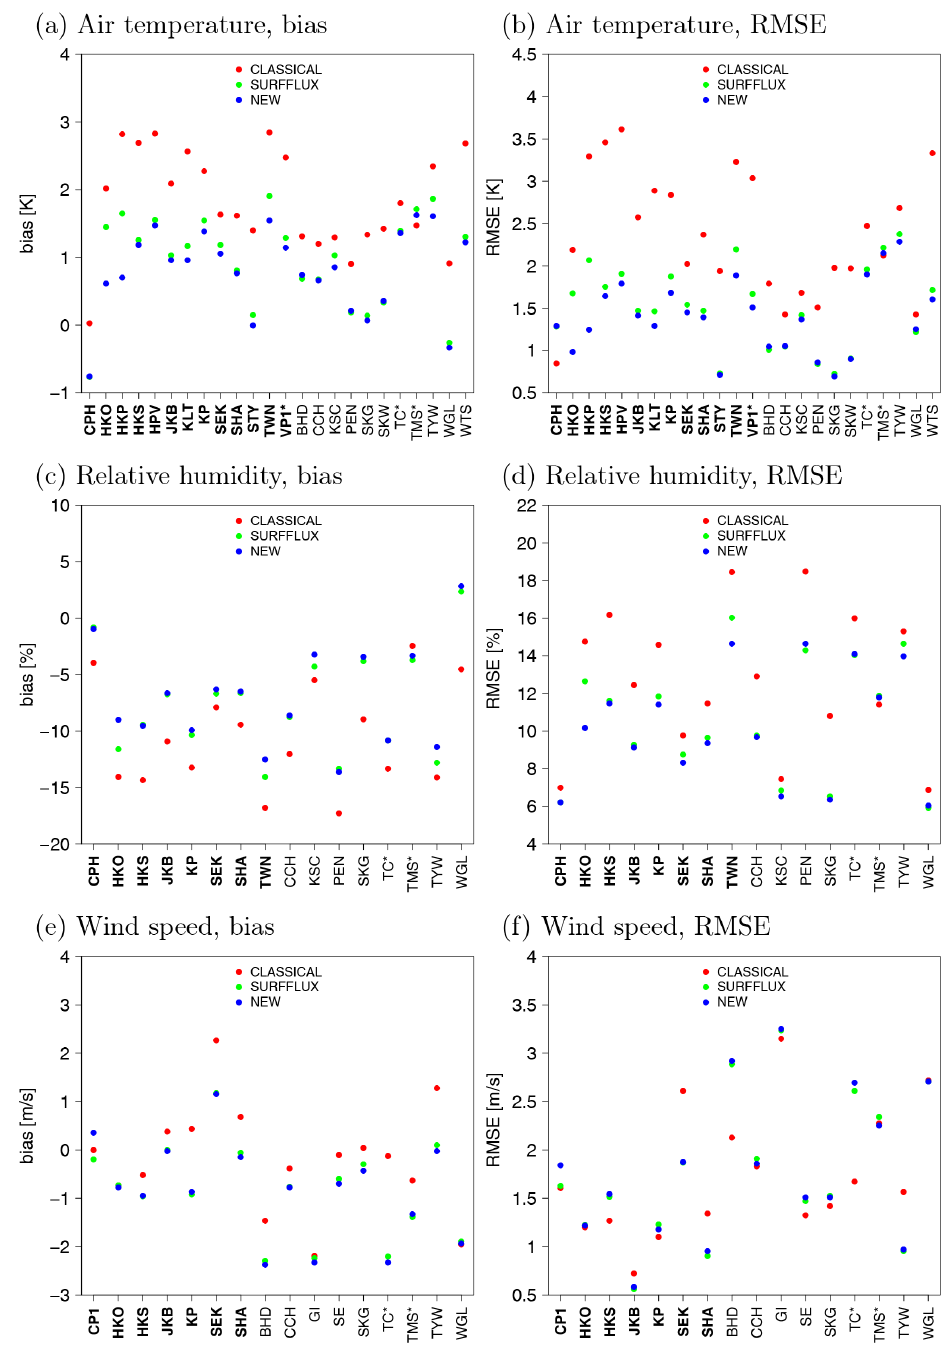
Figure 9. Same as Fig. 8 but for